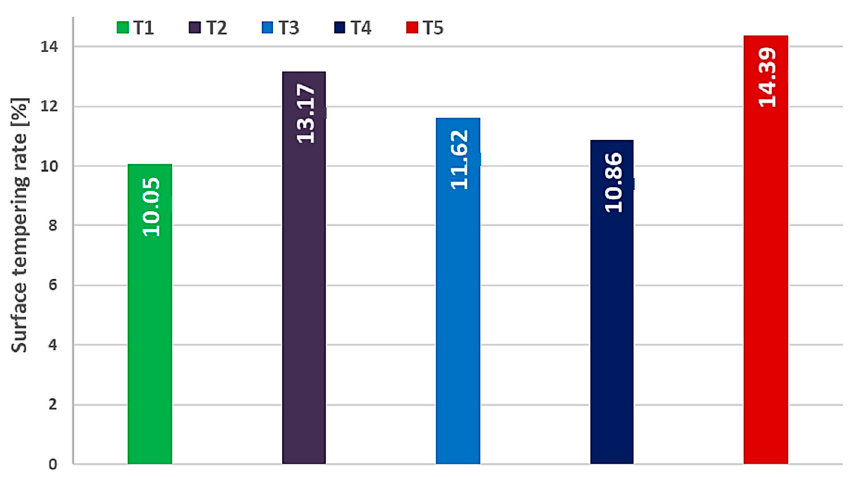
Figure 10. Surface tempering rate of the material processed with the feed f 3 = 0.3 mm/rev. depending on the tested tool where: T1–T5—tool type.